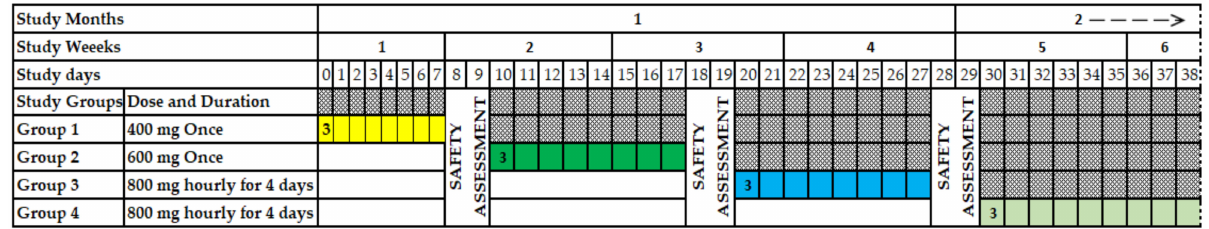
Figure 1. Study design. The yellow color presents the safety assessment days for group 1; the green color presents the safety assessment days for group 2; the light blue color presents the safety assessment days for group 3; and the light green color presents the safety assessment days for group